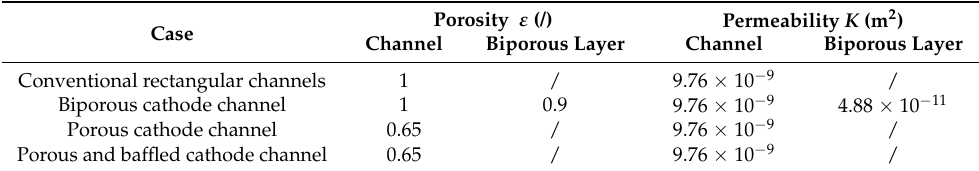
Table 3. Porosity and permeability of channel and biporous